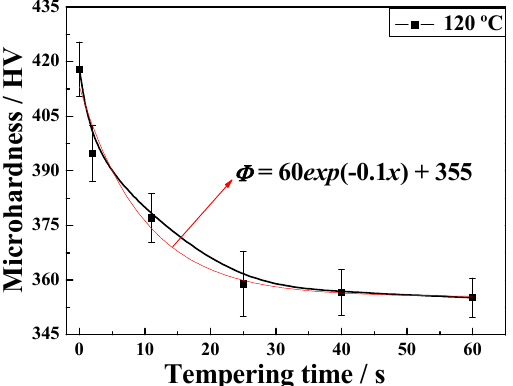
Figure 11. Microhardness of samples quenched at 120 °C and tempered for different lengths of time.